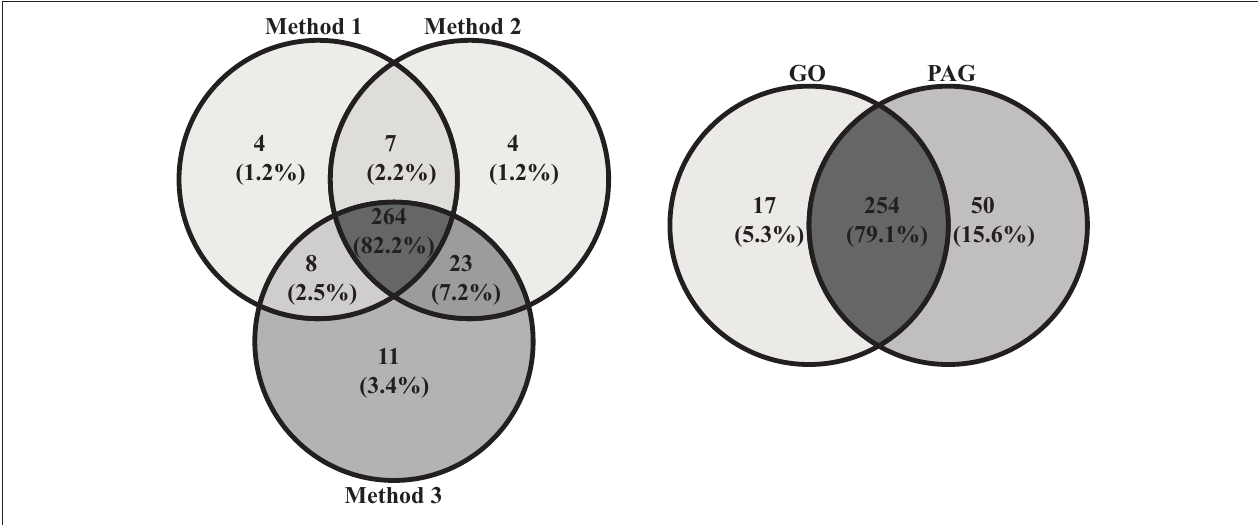
FIGURE 3 | Venn diagrams comparing number of OTUs within and between the PAG and the GO, as well as within and between the three different methods.